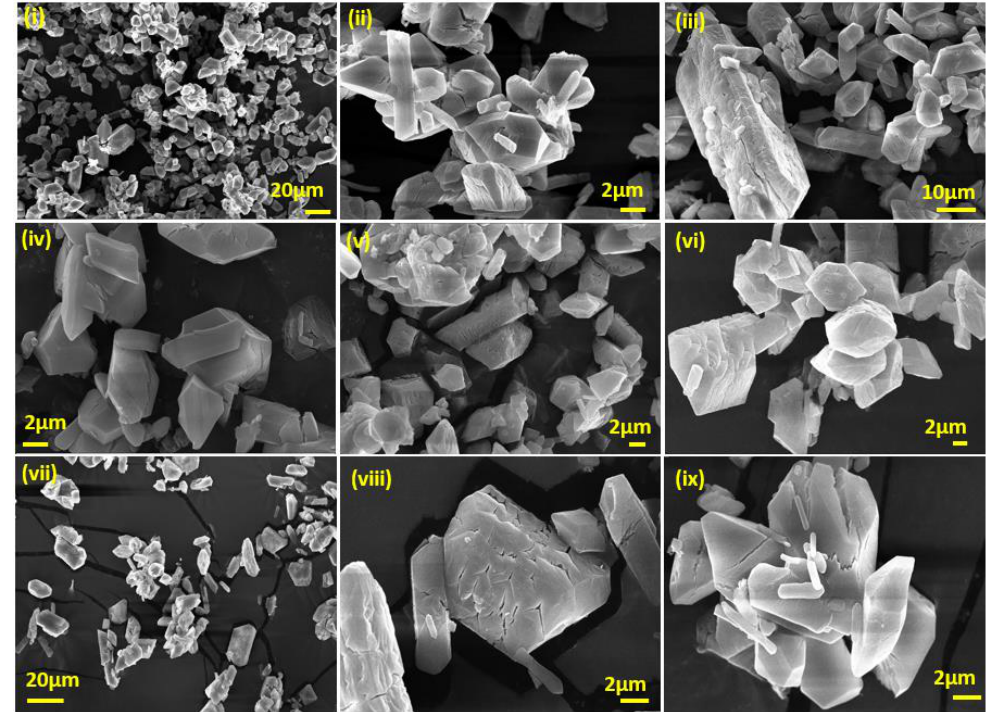
Figure 14. Scanning electron microscopy (SEM) photographs of struvite spontaneously precipitated in presence of SWW. ( i – iii ) σ struvite =0.29 ( iv – vi ) σ struvite =4.45 and ( vii – ix ) σ struvite =6.76.